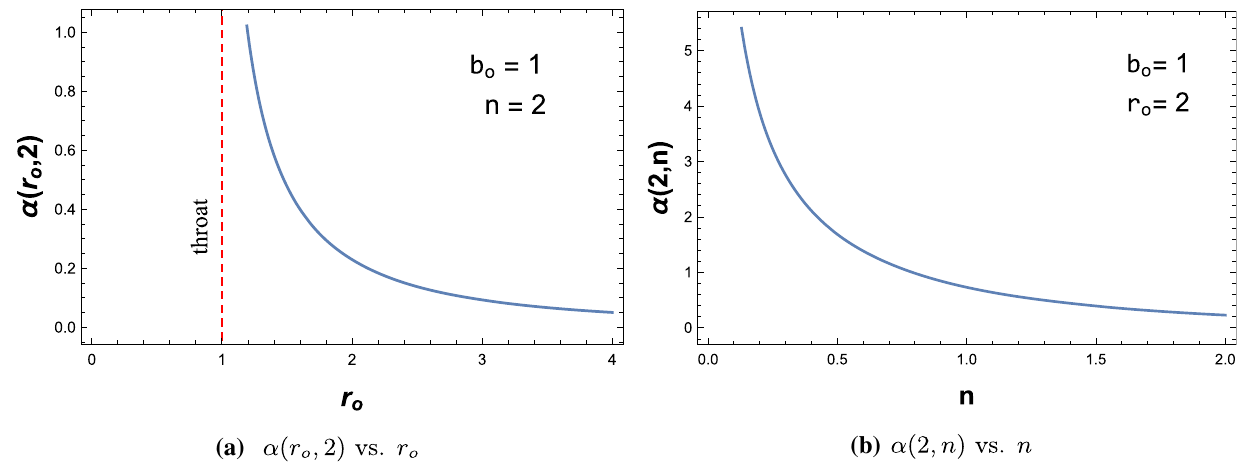
Fig. 1 The figures show how α( r o , n ) depends upon its parameters a α( r o , 2 ) vs. r o , b α( 2 , n ) vs.